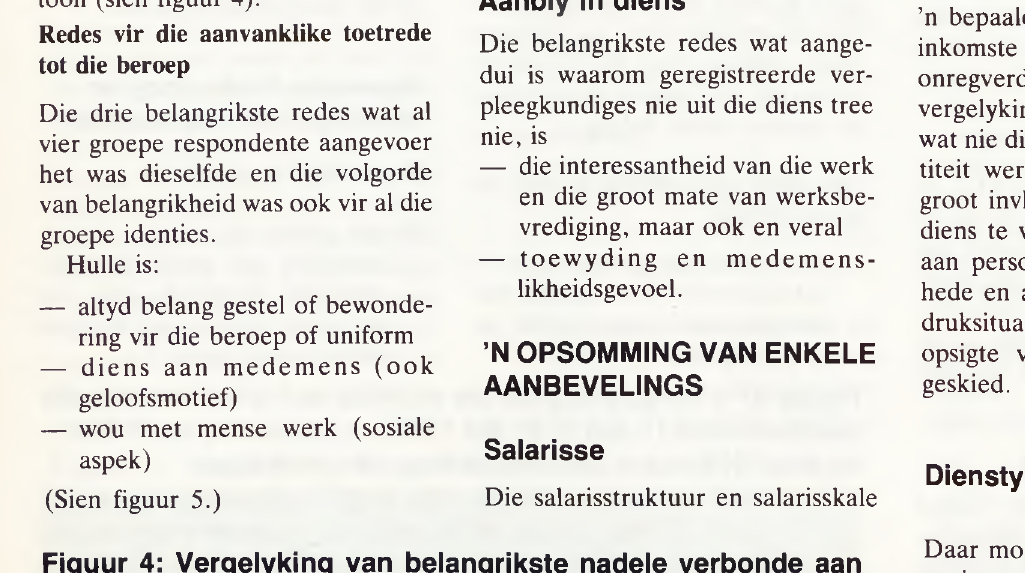
Figuur 4: Vergelyking van belangrikste nadele verbonde aan